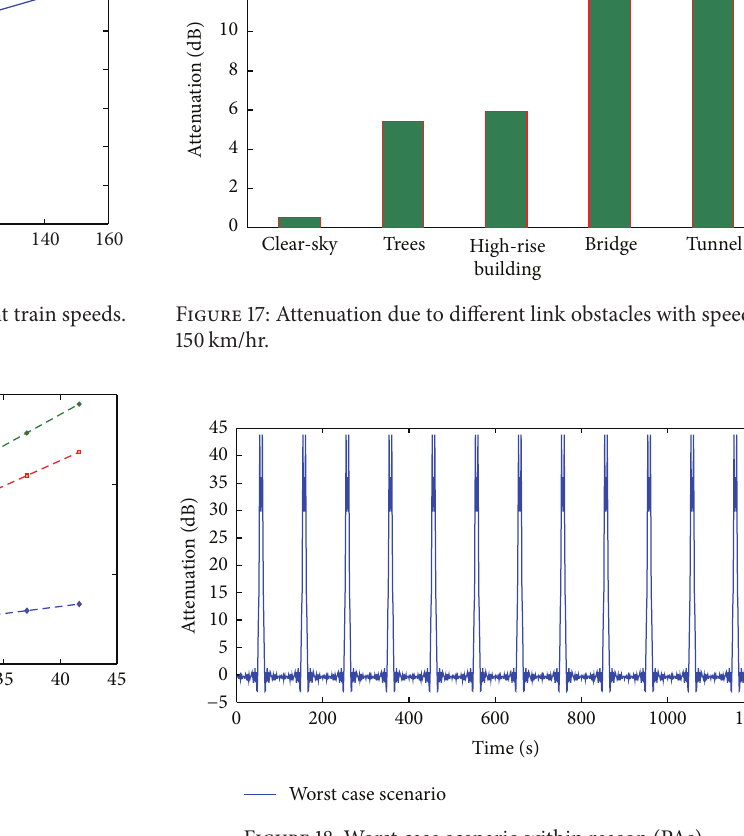
Figure 18: Worst case scenario within reason